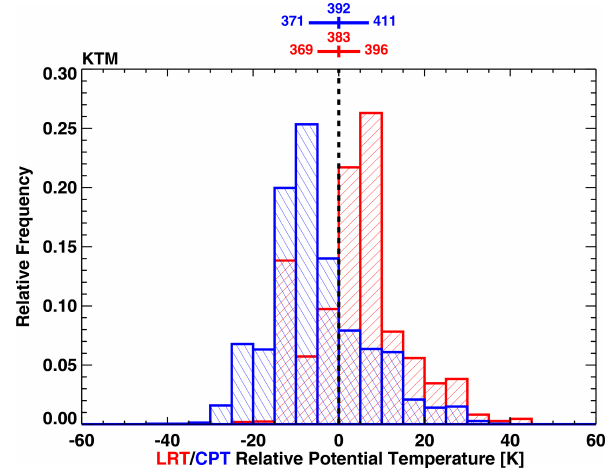
Figure 7. Transition layer in tropopause-relative potential temper- ature coordinates. Histograms show normalized relative frequency distributions of transition layer measurements as defined in the text. The distribution relative to the LRT (CPT) is shown in red (blue). The mean and the range of the LRT and CPT in potential tempera- ture coordinates (as shown in Fig. 4) are given in matching colours above the zero